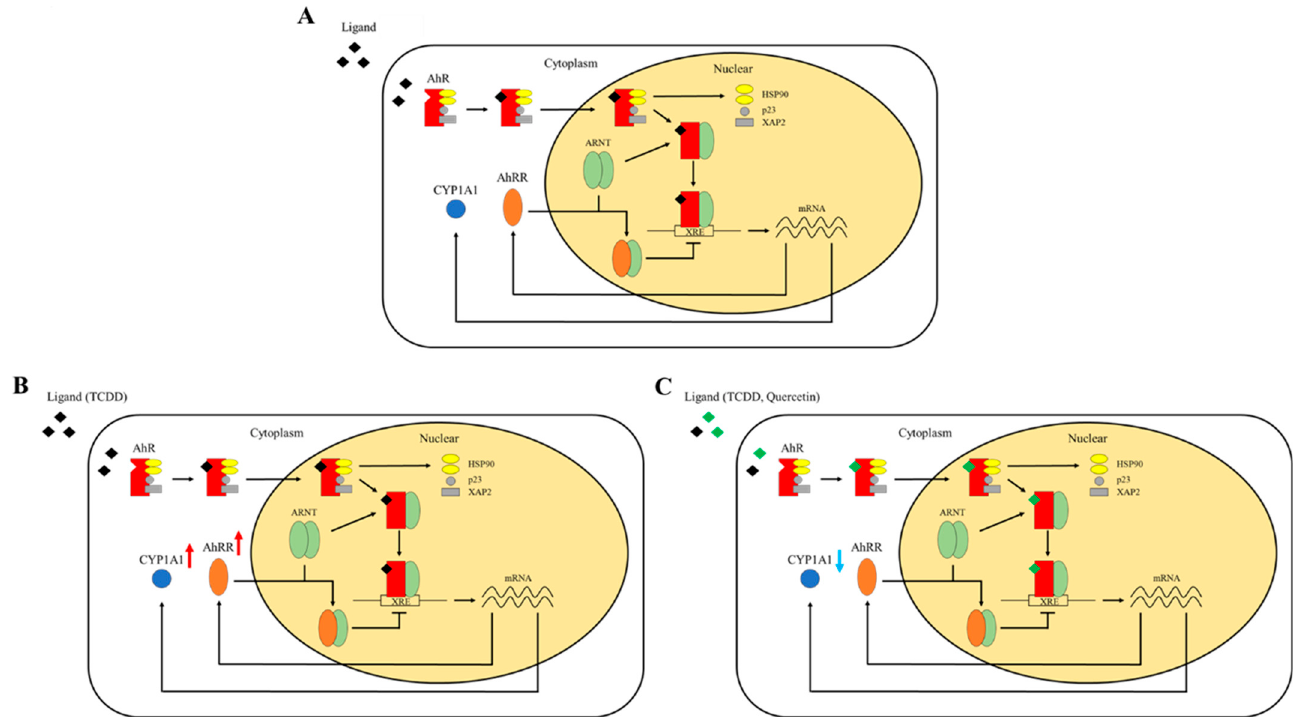
Figure 5. ( A ) The AhR pathway. AhR is present in the cytoplasm bound to two molecules of heat shock protein of 90 kDa (HSP90), X-associated protein 2 (XAP2), and the 23 kDa cochaperone protein (p23) [7]. Since TCDD and quercetin are lipophilic, they can easily permeate the cell membrane and bind to AhR as its ligands in the cytoplasm. AhR that binds to its ligand undergoes a conformational change and enters the nucleus in a complex with HSP90 and other molecules [24]. Upon entry into the nucleus, the AhR complex dissociates HSP90, XAP2, and p23 to form a heterodimer with aryl hydrocarbon receptor nuclear translocator (ARNT). This heterodimer of AhR and ARNT binds to xenobiotic responsive element (XRE), which activates the expression of various genes, including CYP1A1 [25]. AhRR has been reported to be involved in a negative feedback mechanism of AhR. AhRR forms a heterodimer with ARNT. Therefore, AhRR represses AhR transcriptional activity by competitively binding to ARNT [26]. ( B ) When TCDD binds to AhR as a ligand, both CYP1A1 and AhRR expression levels are significantly increased compared to the CTRL group. ( C ) When TCDD and quercetin bind to AhR as ligands, the expression level of AhRR is significantly increased compared to the CTRL group, but the expression level of CYP1A1 is not significantly different. Compared to the TCDD group, the expression level of AhRR is not significantly different, but the expression level of CYP1A1 is significantly decreased.